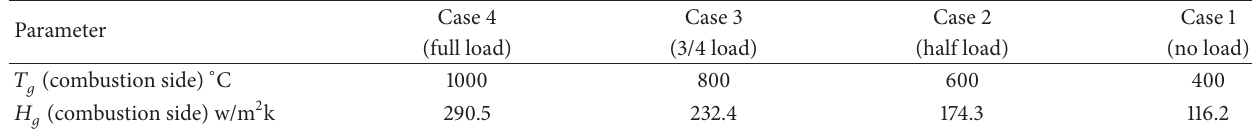
Table 3: Heat transfer parameter for four different cases of engine loading.